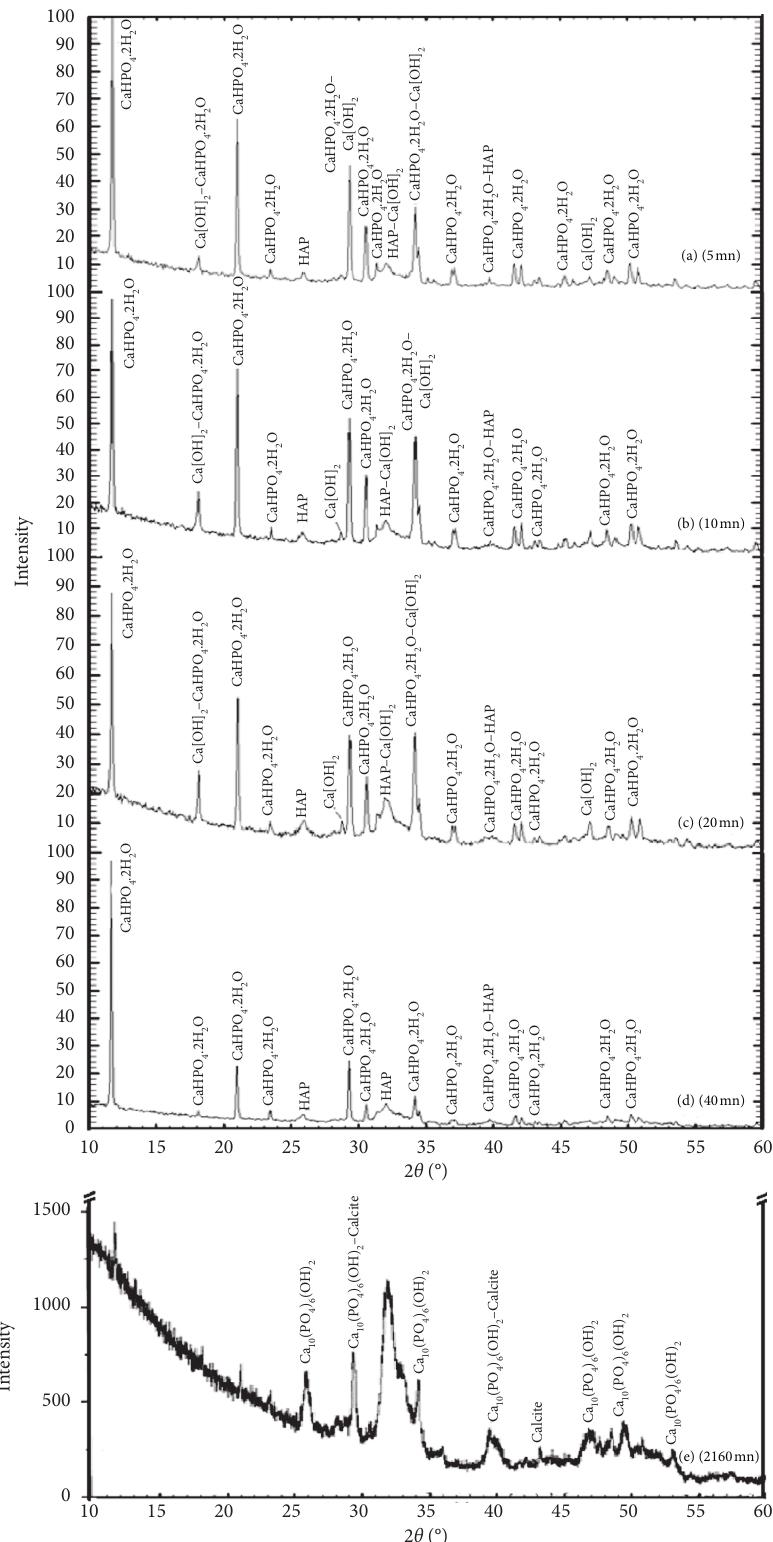
Figure 3: X-ray diagrams of the solid phase taken from mixture M 1 as a function of time: (a) at 5min, (b) at 10min, (c) at 20 min, (d) at 40min, and (e) at